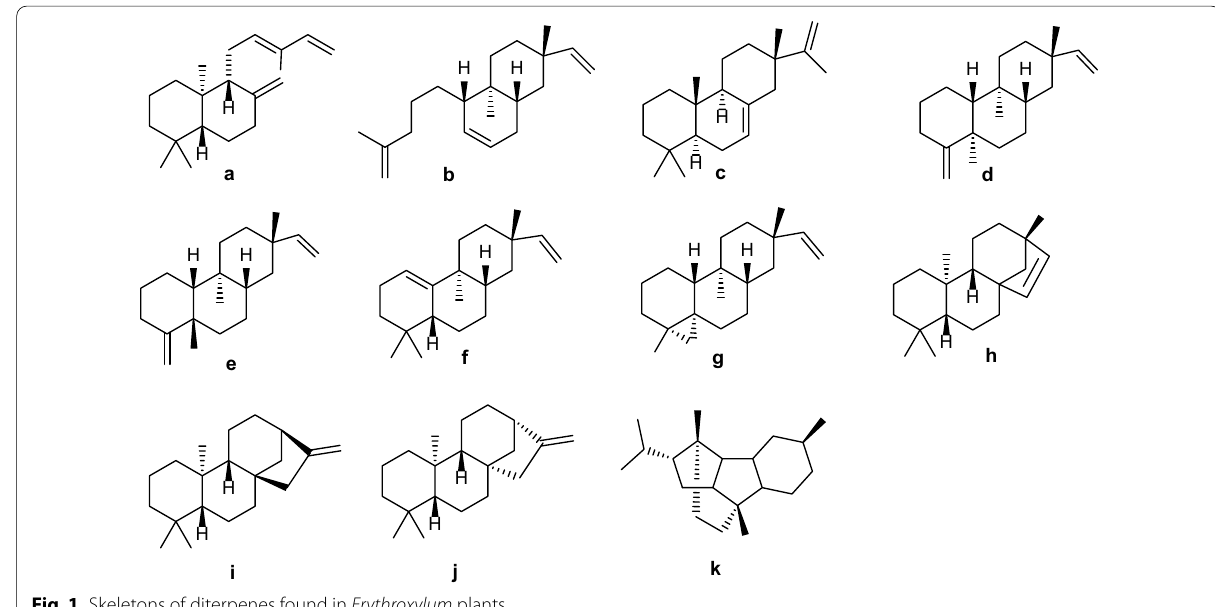
Fig. 1 Skeletons of diterpenes found in Erythroxylum